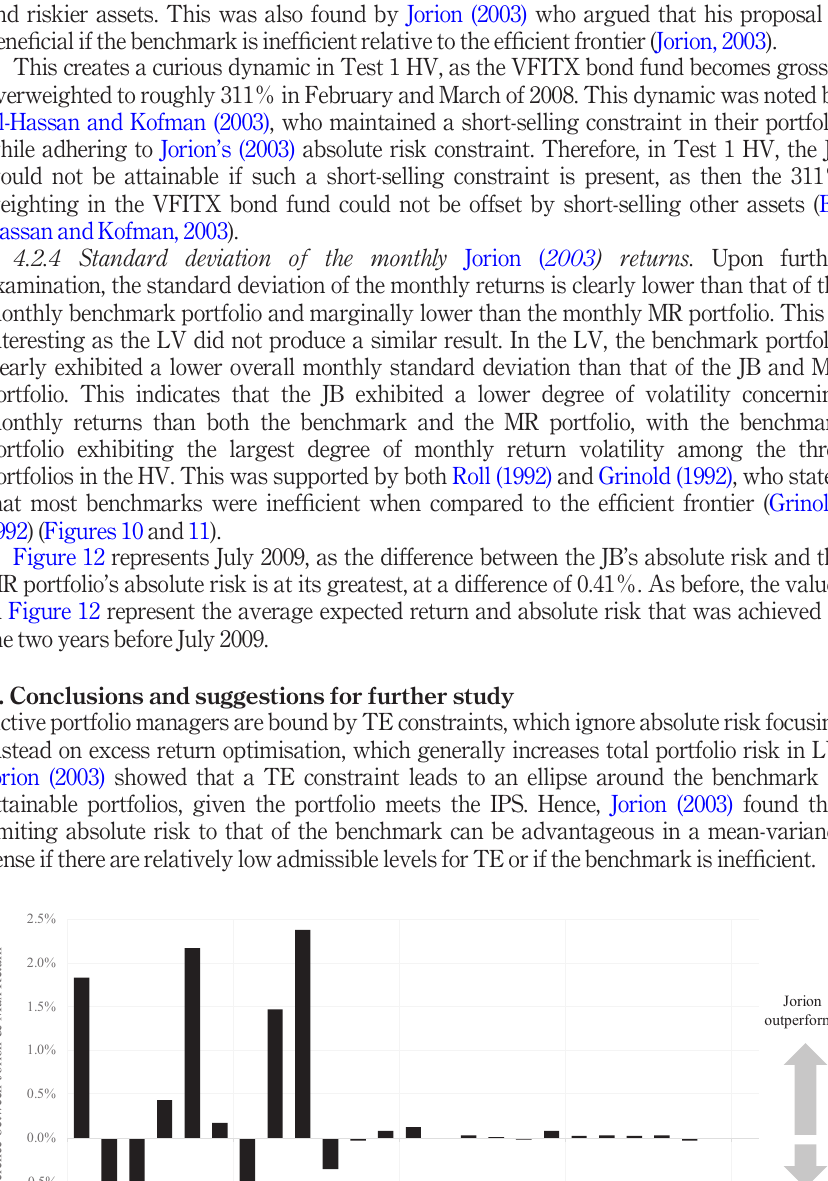
difference between JB and MR